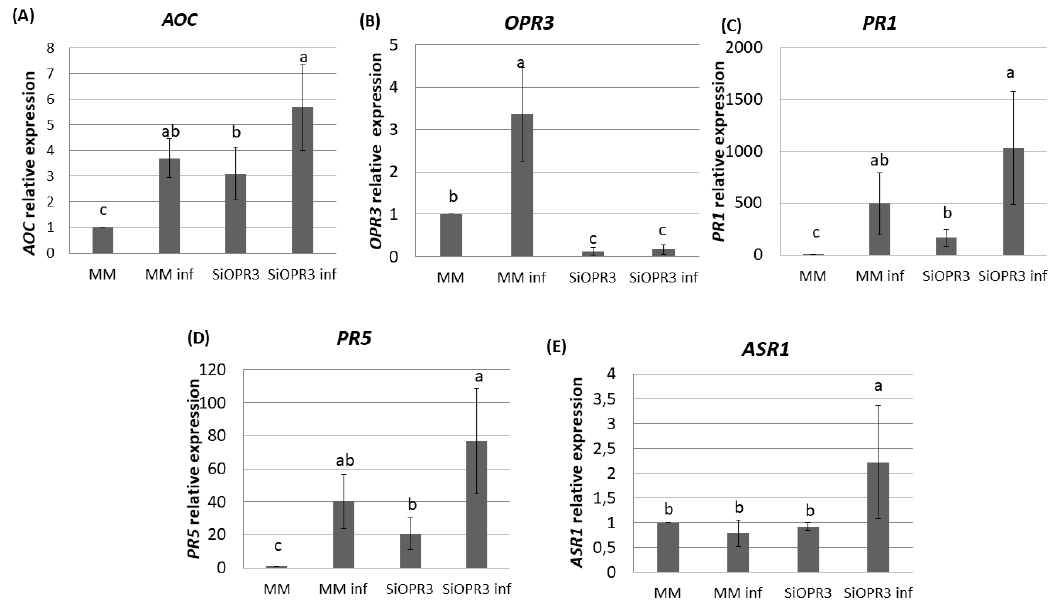
Figure 3. Gene expression profile of plant defense pathways in MM and SiOPR3 plants upon Pst infection. MM and SiOPR3 plants were grown and inoculated as described in Materials and Methods. The expression of the AOC ( A ), OPR3 ( B ), PR1 ( C ), PR5 ( D ), and ASR1 ( E ) genes were analyzed in cDNA from MM and SiOPR3 plants at 72 h post-inoculation. The results were normalized to the EF1 α gene expression measured in the same samples. The results show the average values of three independent experiments with similar results ± standard error ( n = 3).